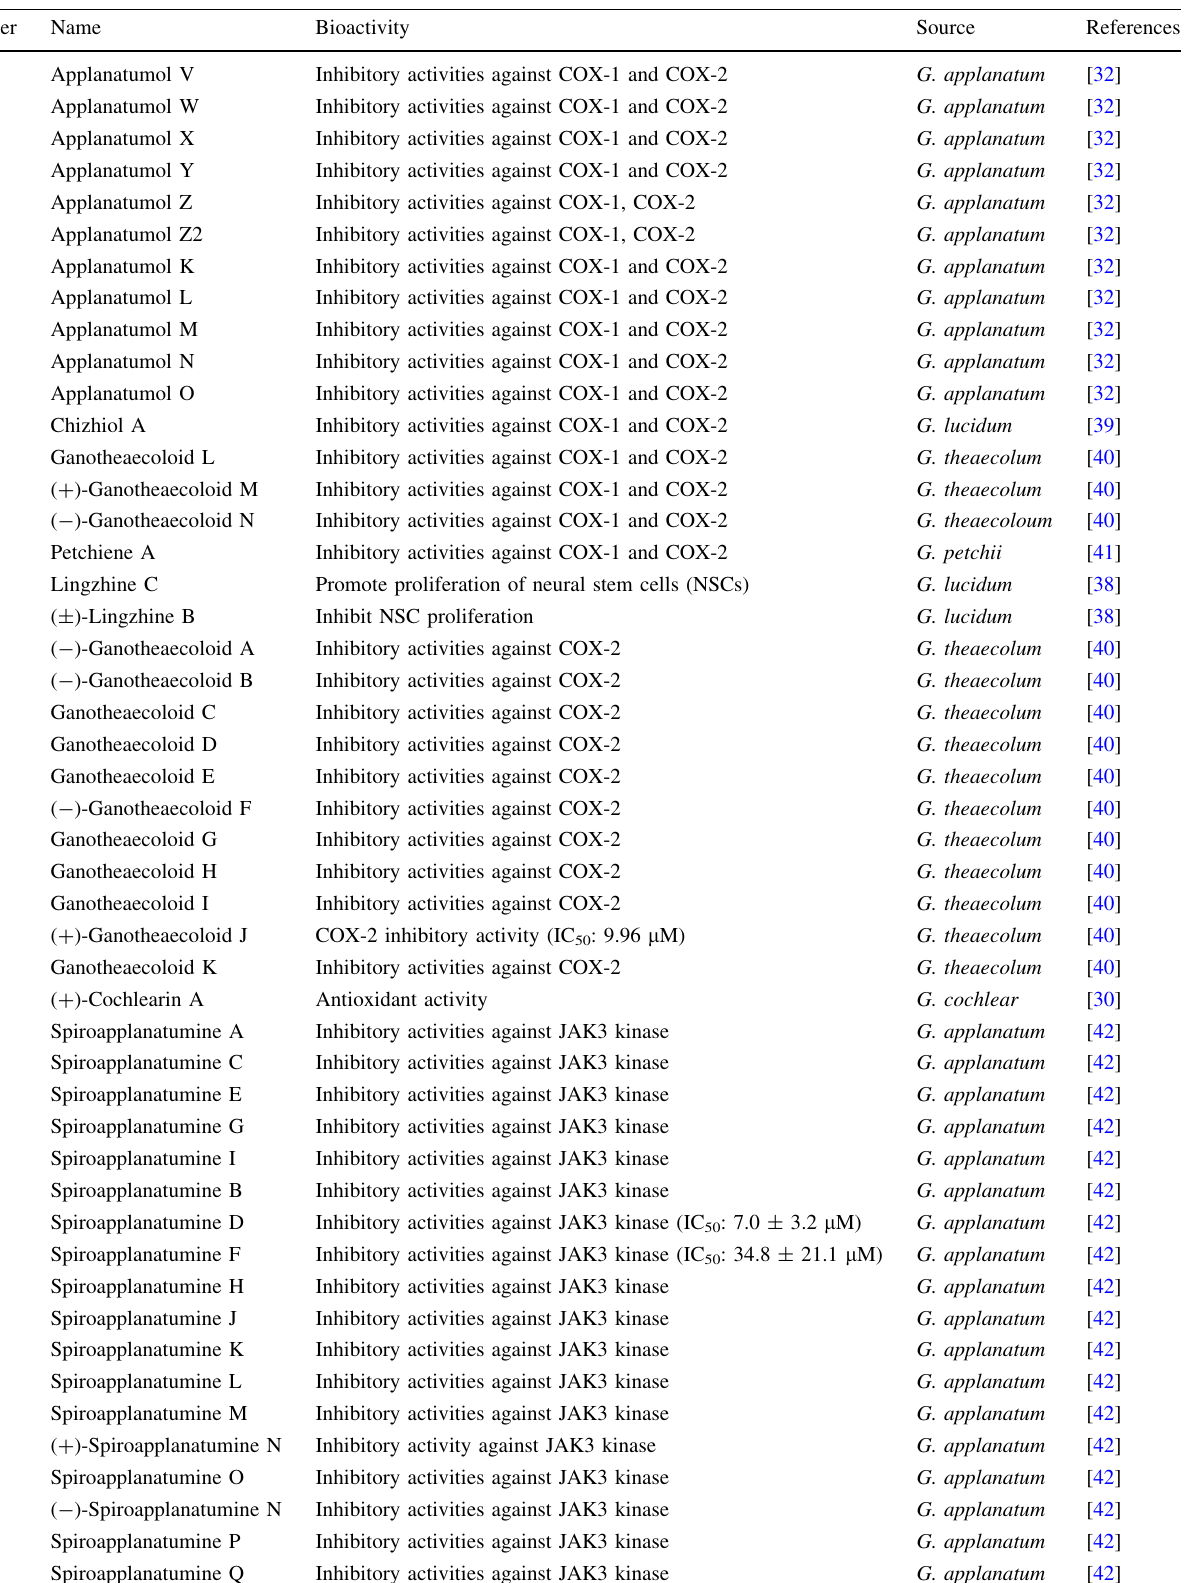
Table 2 Name, source and bioactivities of polycyclic GMs